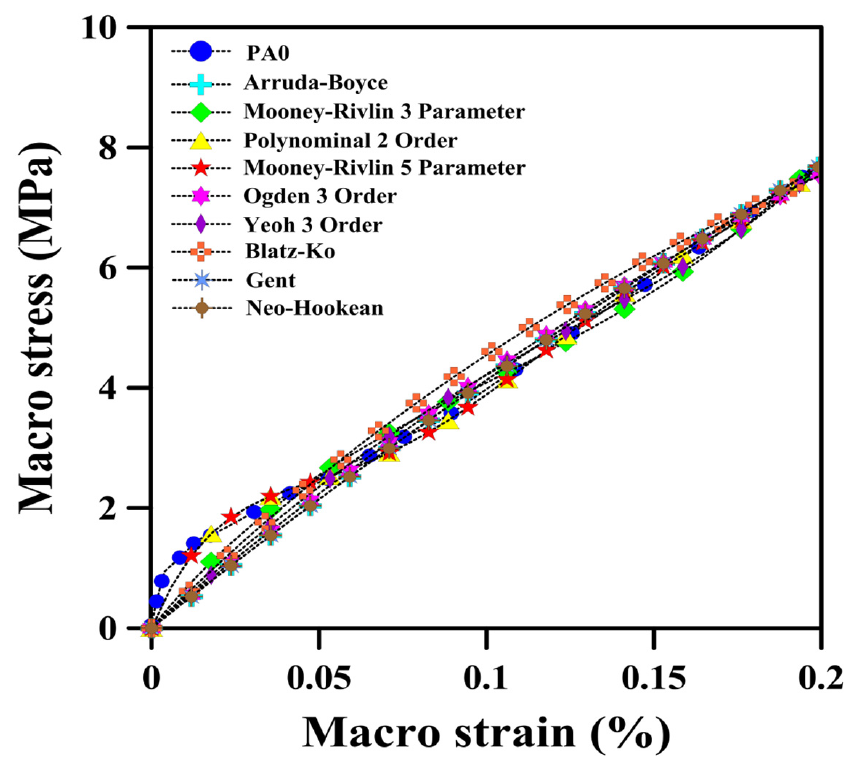
Figure 7. Mechanical behavior of the POE with different hyperelastic models under static loading. Here, as an example, the process of curve fitting and finding the material constant of the strain energy density equation is briefly presented for the Mooney–Rivlin 5 Parameter as a sample of hyperelastic models. From Equation (6), the strain energy equation in the five-parameter Mooney–Rivlin model can be written as: